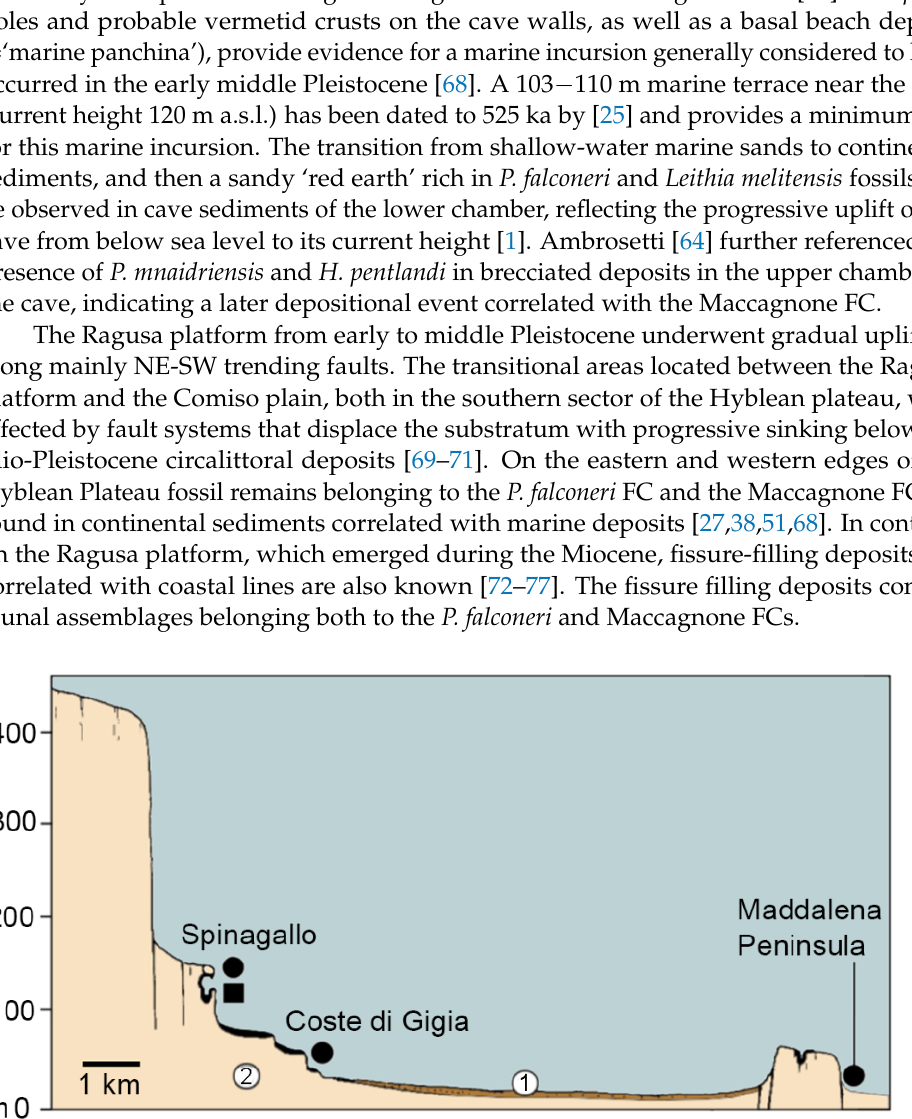
Figure 21. Schematic profile of the eastern edge of the Hyblean Plateau; ① = abrasion platform and calcarenites, ② = substrate, including lower Pleistocene marine deposits. Black squares: older faunal assemblages ( E. falconeri FC). Black circles: younger faunal assemblages (Maccagnone FC). Note the higher position of the Spinagallo Cave, where both faunal assemblages occur.